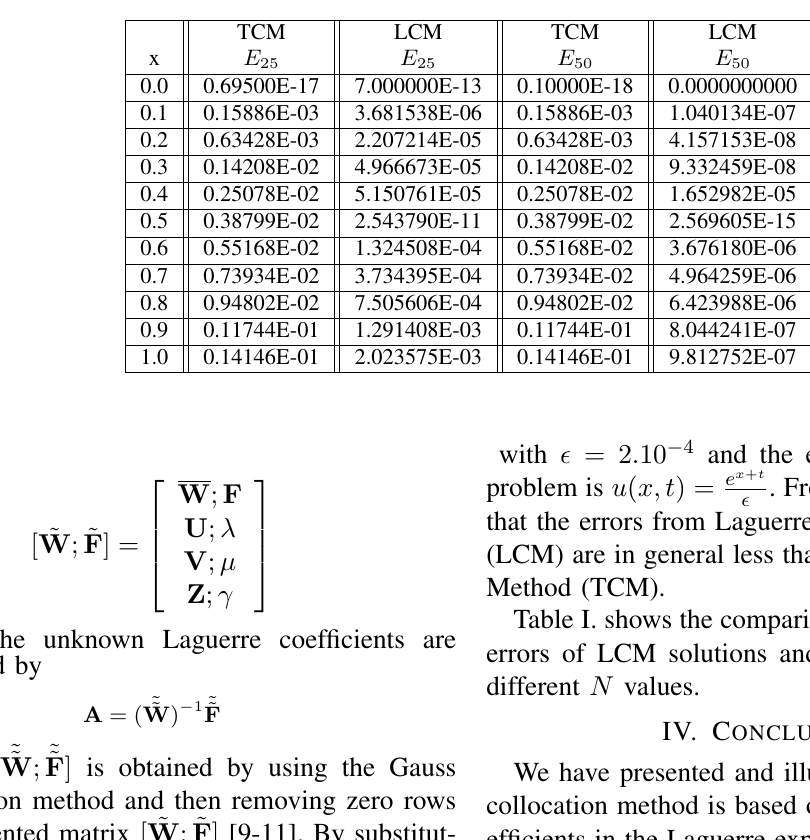
C OMPARISON OF THE ABSOLUTE ERRORS WITH TCM AND LCM FOR N = 25 , 50 IN E XAMPLE 2